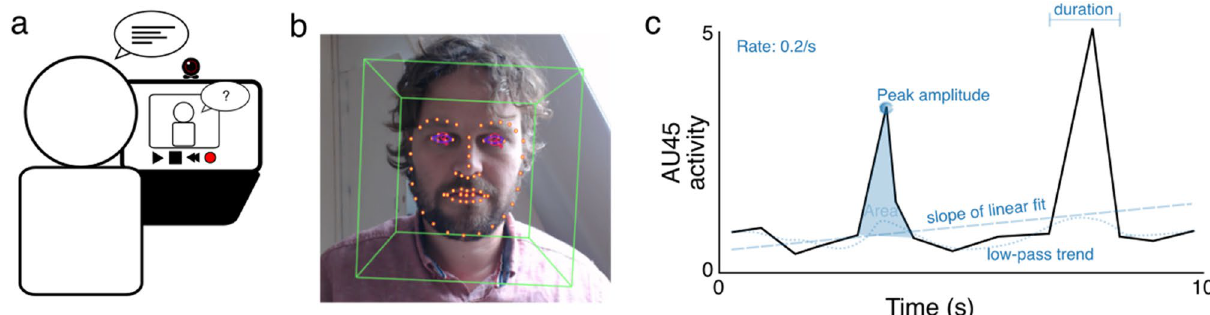
Figure 1. Procedure and feature extraction. ( a ) Candidates’ (participants) faces were recorded while they conducted an automated interview on a computer. ( b ) Example of detected facial markers (orange circles) for action unit activity measurements (person in the image is one of the authors, not a participant, and has approved the use of this image). ( c ) Schematic example of a recording of action unit 45 (eye blinks). The behavioral features extracted from the signal are highlighted in